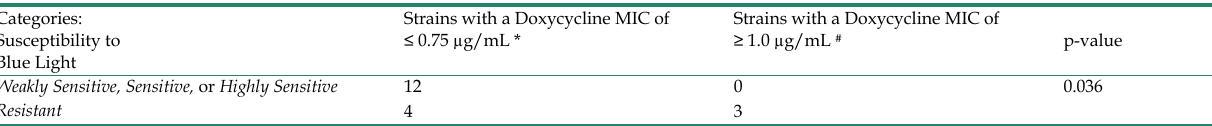
Table 3. Two x Two Contingency Table for Doxycycline Resistance and Blue Light Resistance Categories: Susceptibility